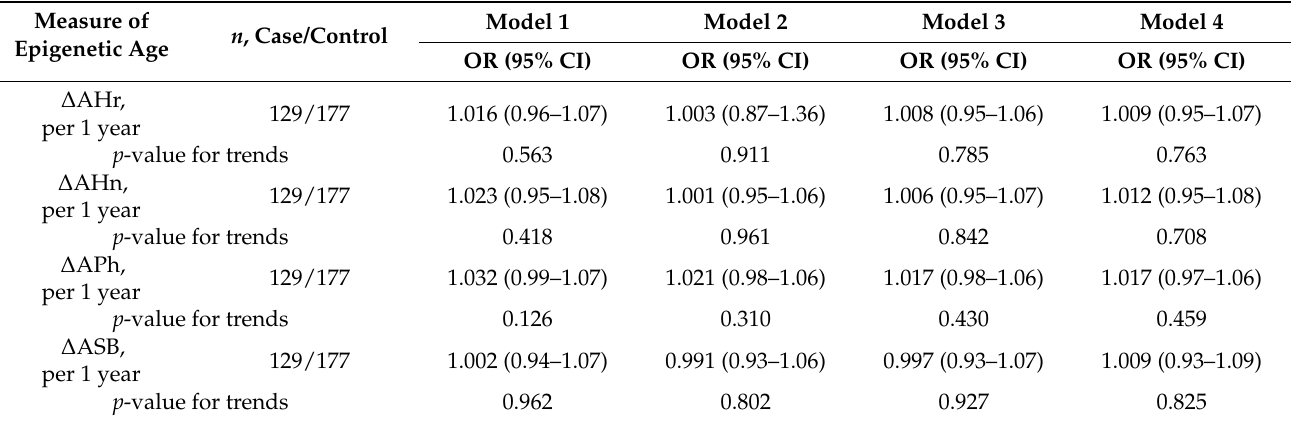
Figure 2. Scatterplots of chronological vs. epigenetic age by Horvath’s, Hannum’s, PhenoAge and Skin and Blood clocks. Diagonal green line corresponds to the predicted age equal to the chronological age, blue straight line corresponds to the linear regression. Table 2. Relationship between MI/ACS and epigenetic age acceleration, per 1–year increment of the difference between baseline EA and CA (cases, n = 129 and controls, n =